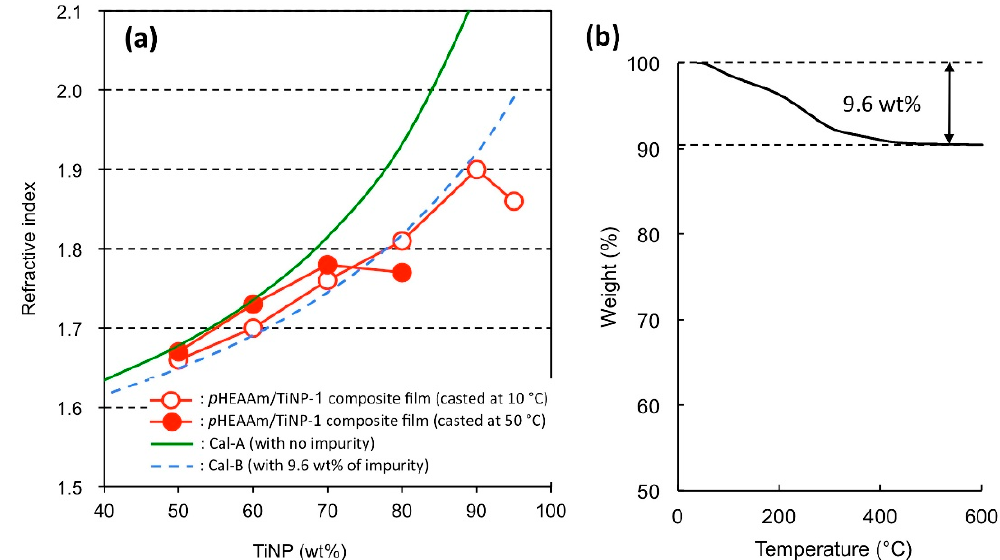
Figure 5. ( a ) Refractive indices of TiNP-1/ p HEAAm composite films under a variety of preparation conditions and ( b ) thermogravimetric (TG) analysis of dried powder prepared from TiNP-1.